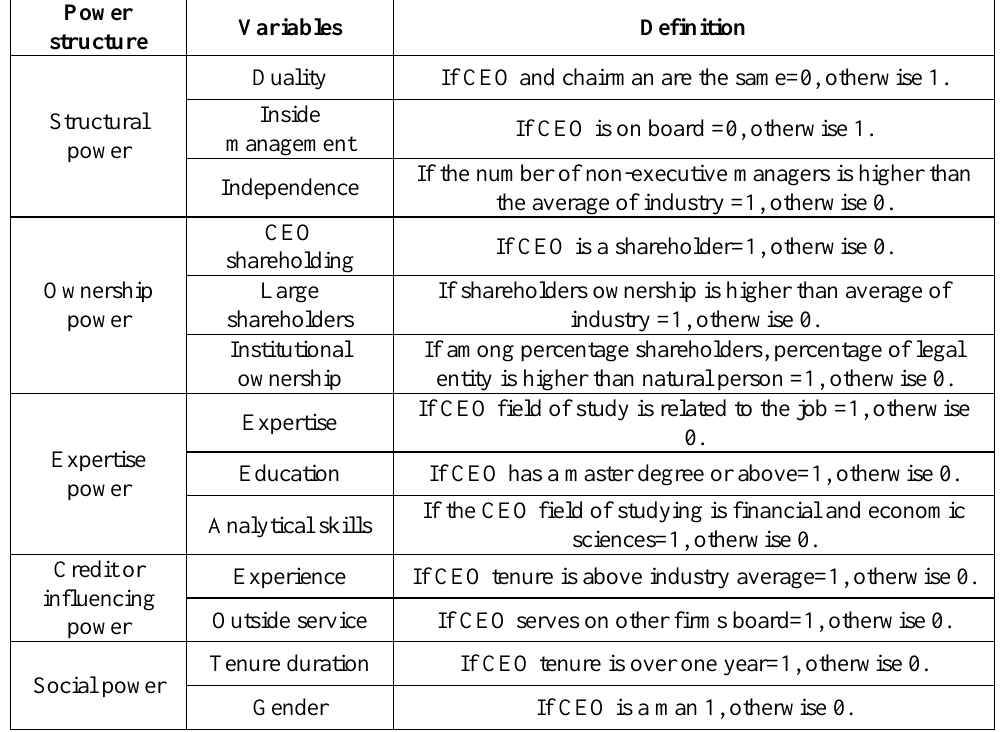
Table 2. components used for calculating CEO